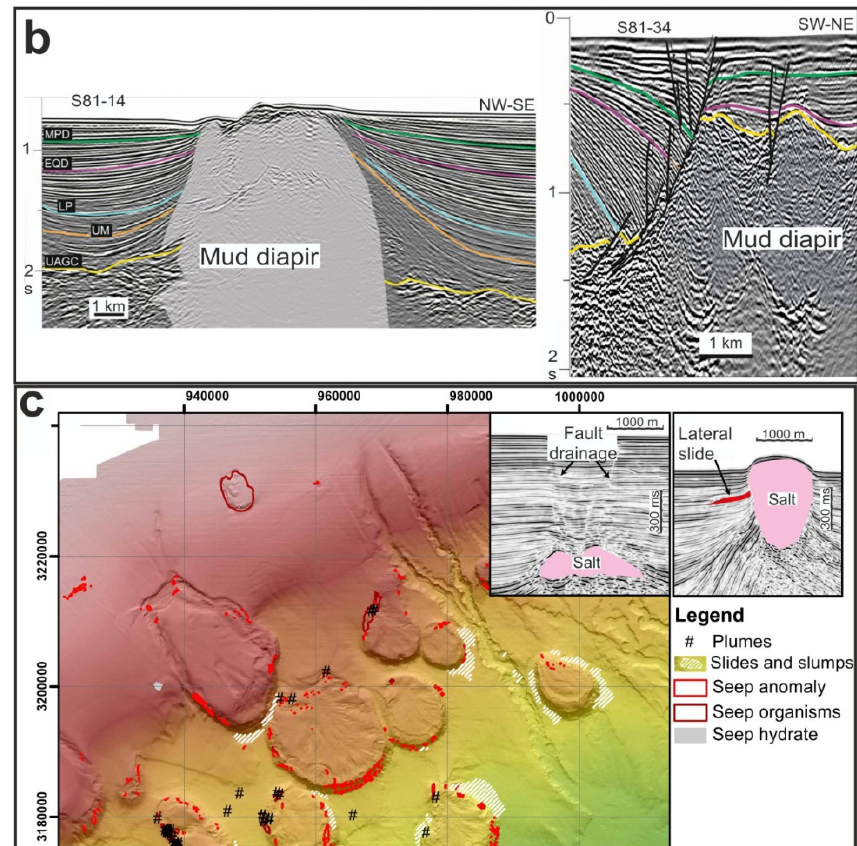
Figure 6. Examples of hazardous features related to fluid flow processes: ( a ) At the top: very high-resolution seismic profile (3.5 kHz) in the Ria de Vigo showing an acoustically blank zone related to the presence of shallow gas accumulations near the seabed (less than 1 meter below the seabed). It also shows the presence of pockmarks and the main paths of gas escape. In the middle: multibeam echosounder images from R í a de Vigo displaying depressions related to gas escapes (pockmarks) and mounds formed by the accumulation of debris (mud and bivalve shells) from mussel rafts. At the bottom: methane-gas bubbles escaping from the sandy and muddy seabed of the R í a de Vigo; ( b ) mud diapirs related to the compressive regime (left figure) and to listric faults (right figure); ( c ) high-resolution bathymetric map of the northeastern Gulf of Mexico showing salt diapirs (rounded positive structures) piercing the seafloor and their associated seep anomalies associated with oil and gas seepages, slides and slumps, and gas hydrates to a lesser extent (images from https://www.boem.gov/oil-gas-energy/mapping-and-data/map-gallery/boem-northern-gulf-mexico-deepwater-bathymetry-grid-3d; accessed on 15 September 2020; https://www.boem.gov/oil-gas-energy/mapping-and-data/map-gallery/seismic-water-bottom-anomalies-map-gallery, accessed on 16 September 2020; https://metadata.boem.gov/geospatial/WBA_Metadata.xml, accessed on 16 September 2020); more details on the northeastern Gulf of Mexico salt diapirs in [128,129]). Enclosed seismic records show: a detailed view of salt-related normal faults acting as drainage pathways for deep fluids and lateral slides associated with overburden salt diapirs in a 2D seismic line located in the Gulf of Lion, western Mediterranean Sea.